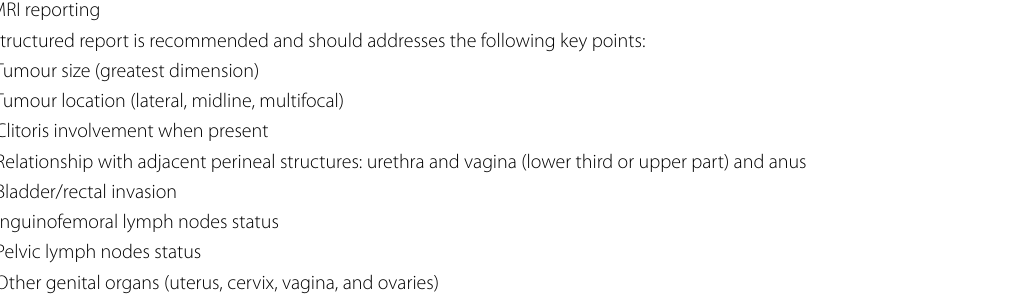
Table 3 Recommended MRI structured report in vulvar cancer staging MRI